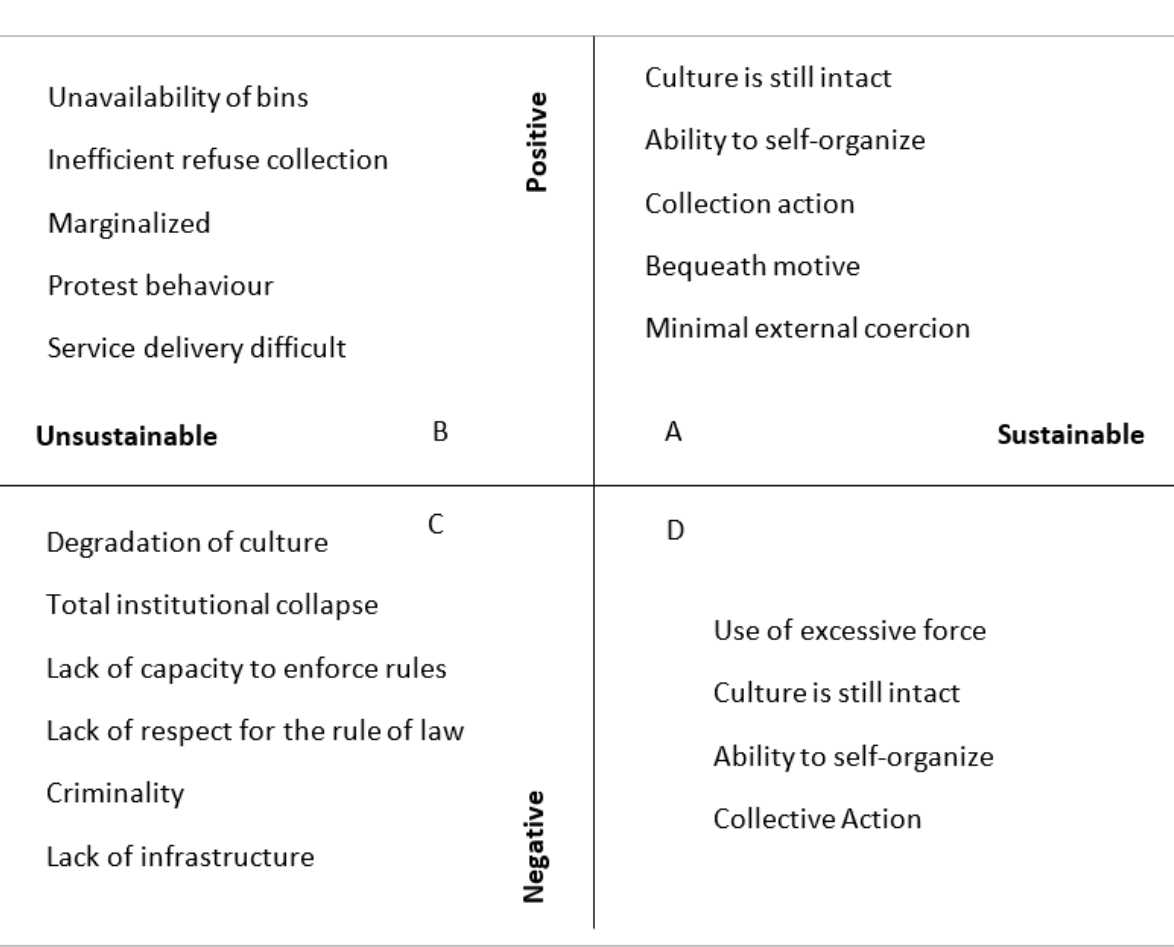
Figure 3. (A–D) A framework for analysing perceptions and environmental behaviour. Source: Figure 3. ( A – D ) A framework for analysing perceptions and environmental behaviour. Source: Authors.